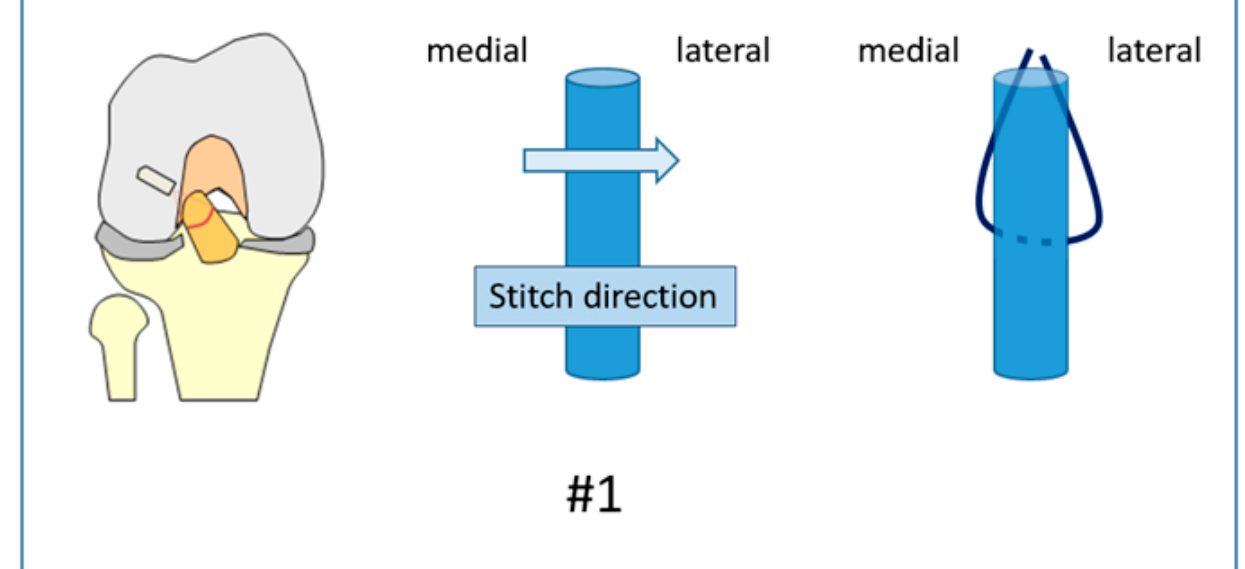
Figure 1. Suture #1 was a simple stitch passing the suture from the medial aspect of the ACL to the lateral.